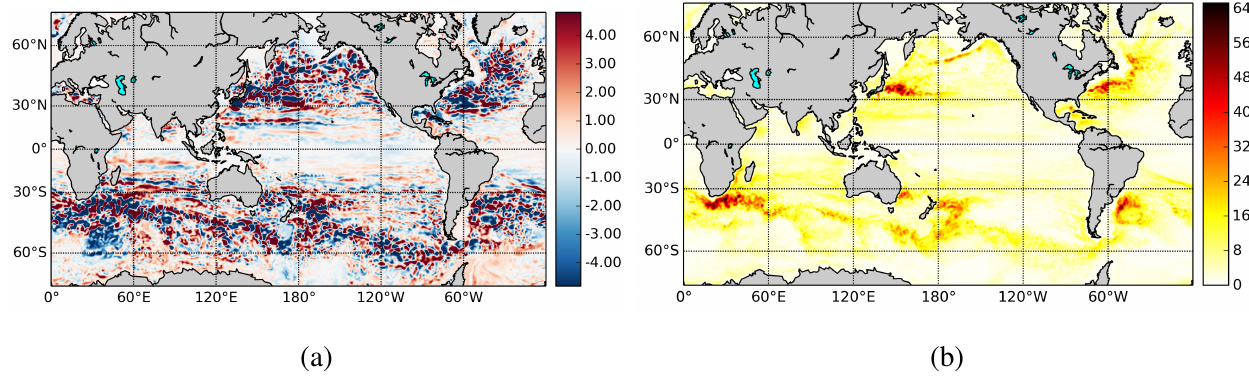
datasets and corresponding number of network vertices and edges.